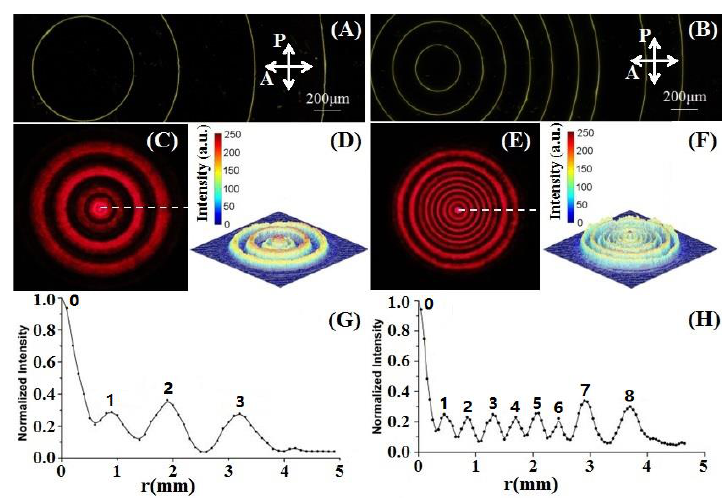
Figure 2. Micrographs of two LC CDGs and their far-field light intensity distributions. ( A , B ) Micrographs of the three-order and the eight-order LC CDGs, respectively. Line scales represent 200 μm. ( C , E ) Far-field diffraction patterns for the three-order and the eight-order LC CDGs, respectively. ( D , F ) Corresponding light intensity profiles for the two LC CDGs. ( G , H ) Light intensity distributions along the white dashed lines in (C,E), respectively.